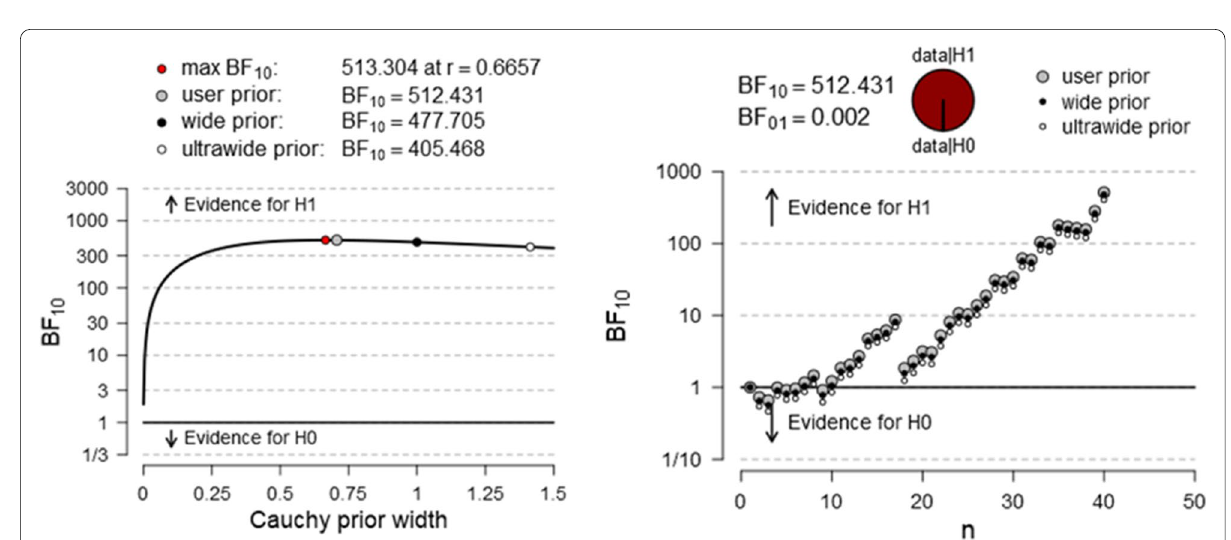
Fig. 4 Bayes factor robustness check for differences between LDT accuracy on digital and paper